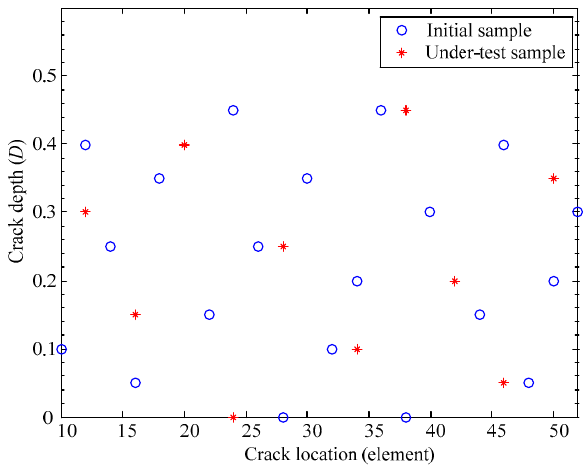
Figure 7. Initial samples and under-test samples.